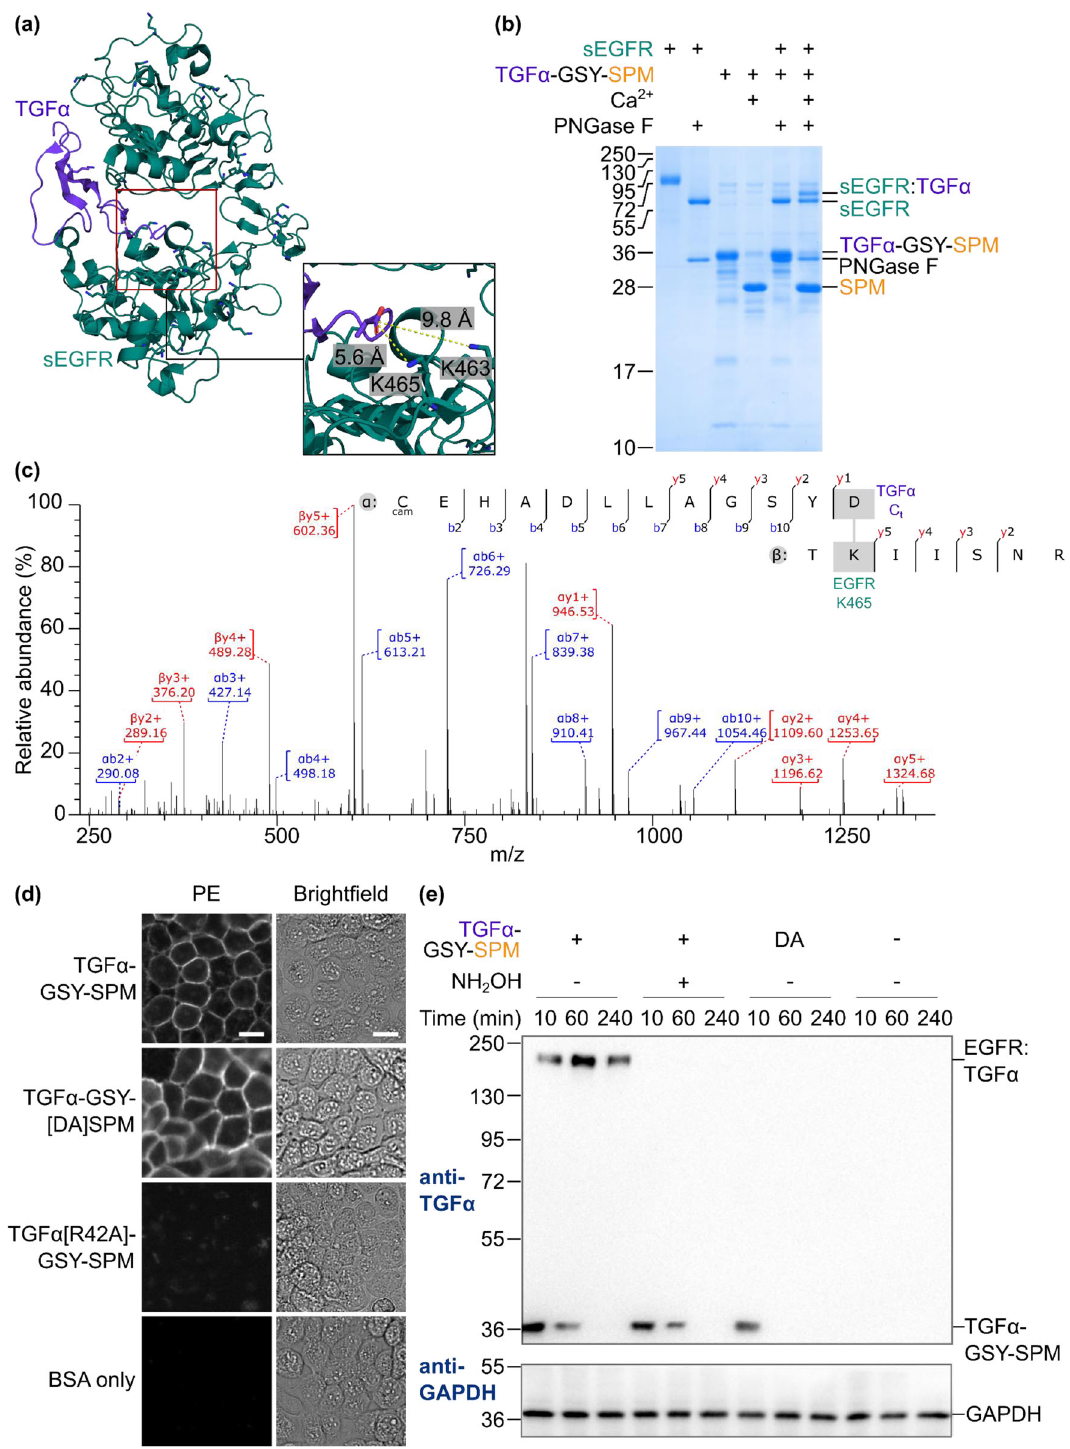
Fig. 6 NeissLock for cellular labeling. a Crystal structure of complex between the extracellular region of EGFR (green) and TGF α (purple) (PDB 1mox). Inset shows the C-terminus of TGFa (chain C) and the distance to the nearest amines. b NeissLock reaction with soluble EGFR. TGF α -GSY-SPM was incubated with sEGFR ± Ca 2 + for 5 h at 37 °C, before SDS-PAGE with Coomassie staining. PNGase F deglycosylation simpli fi ed sEGFR mobility. c MS mapping of the crosslink. Tryptic LC – MS/MS from reaction of TGF α -GSY-SPM with sEGFR identi fi ed a crosslink at K465. cam = carbamidomethylated. d TGF α -GSY-SPM retained speci fi c binding to cell-surface EGFR. A431 cells were incubated with TGF α -GSY-SPM, non-reactive TGF α -GSY-[DA]SPM or reduced-binding TGF α [R42A]-GSY-SPM each at 5 µ M or with BSA buffer control, before wide- fi eld fl uorescence microscopy. Bright fi eld and PE (detecting His-tag) fl uorescence images are shown. Scale bar 20 µ m. e NeissLock conjugation was speci fi c to EGFR on cells and was abolished by addition of hydroxylamine. A431 cells were labeled for 10 min with 1 µ M TGF α -GSY-SPM or non-reactive TGF α -GSY-[DA]SPM with 2 mM Ca 2 + and ± hydroxylamine. Cells were incubated for the indicated time and blotted against TGF α . GAPDH was the sample processing control. Molecular weight markers represent kDa. Source data are provided as a Source Data fi